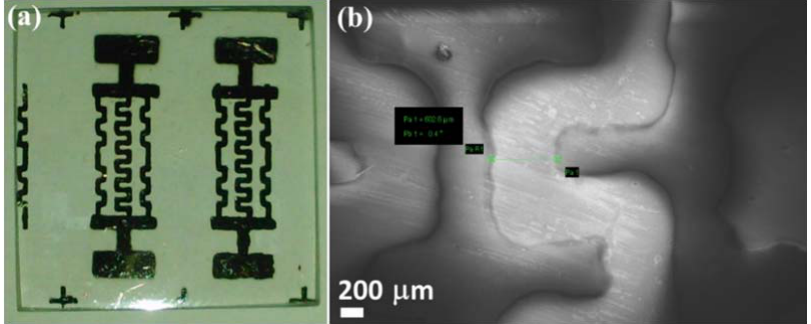
Figure 5. (a) Optical digital image of a real micro-heater; and (b) SEM image of microheater on glass substrate.